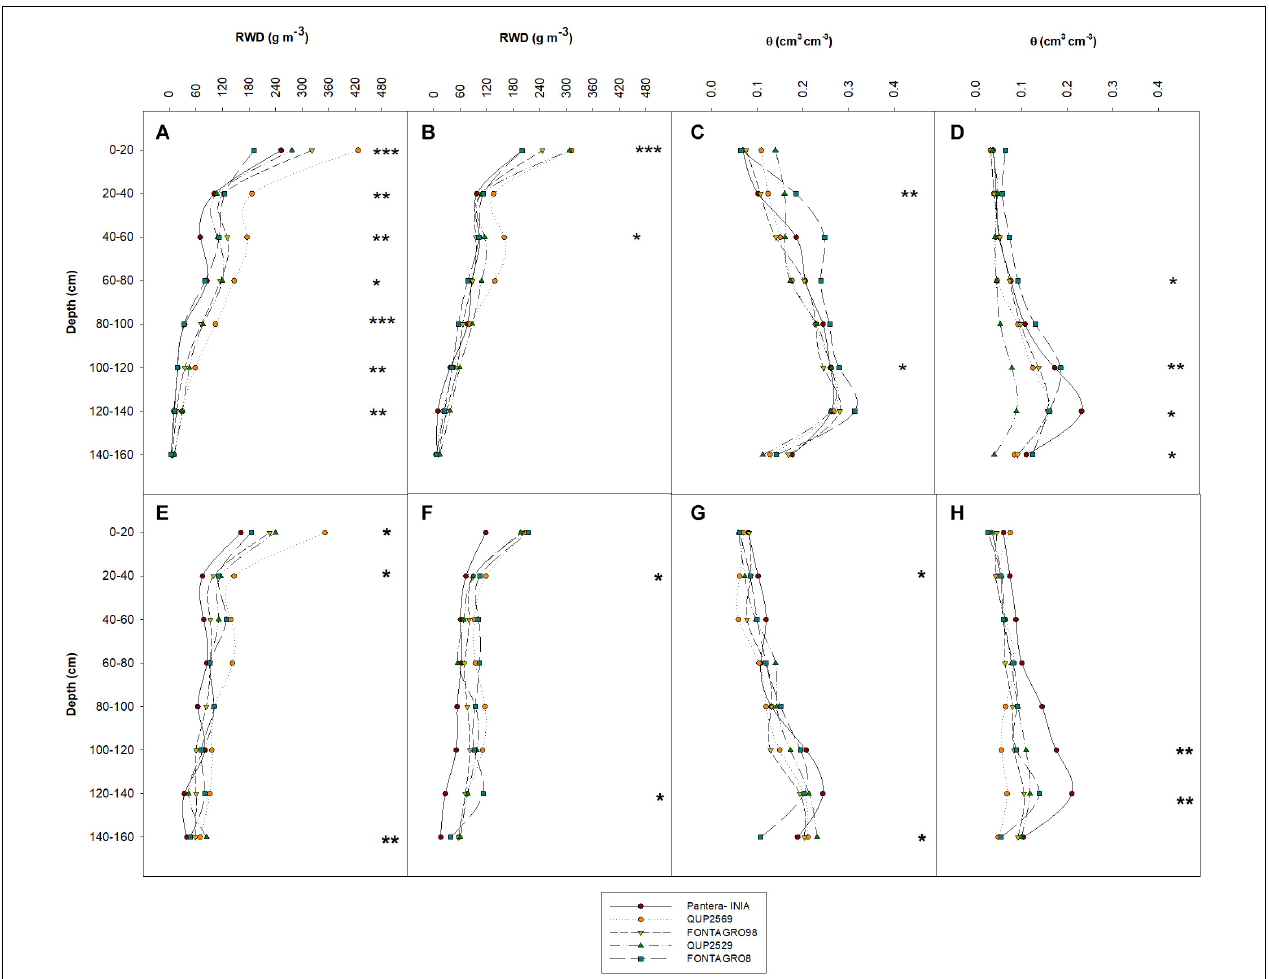
FIGURE 2 | Distribution of root biomass (A,B,E,F) and soil water content (C,D,G,H) in depth at anthesis of five spring wheat genotypes with contrasting tolerance to water deficit, grown under well-watered (A,E,C,G) and water-limited conditions (B,F,D,H) , in tubes of 160 cm length in a glasshouse in 2016 (A–D) and 2017 (E–H) . * P ≤ 0.05, ** P ≤ 0.01, and *** P ≤ 0.001 are obtained from ANOVA test of the different genotypes at the different soil column